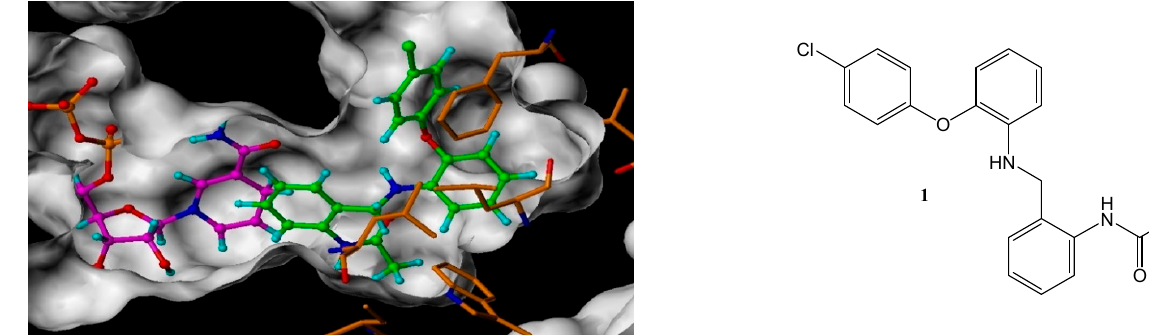
Figure 5. Compound 1 (green) docked in the 17 β -HSD3 homology model showing interactions with the cofactor (cyan) and key amino acid residues (brown). These colours are consistent throughout.